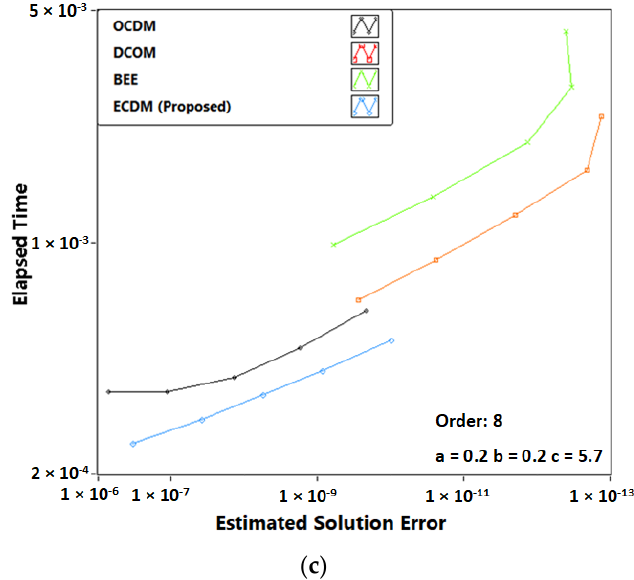
Figure 4. Performance plots for Rössler system simulation using composition solvers of orders 4 ( a ), 6 ( b ), and 8 ( c ).